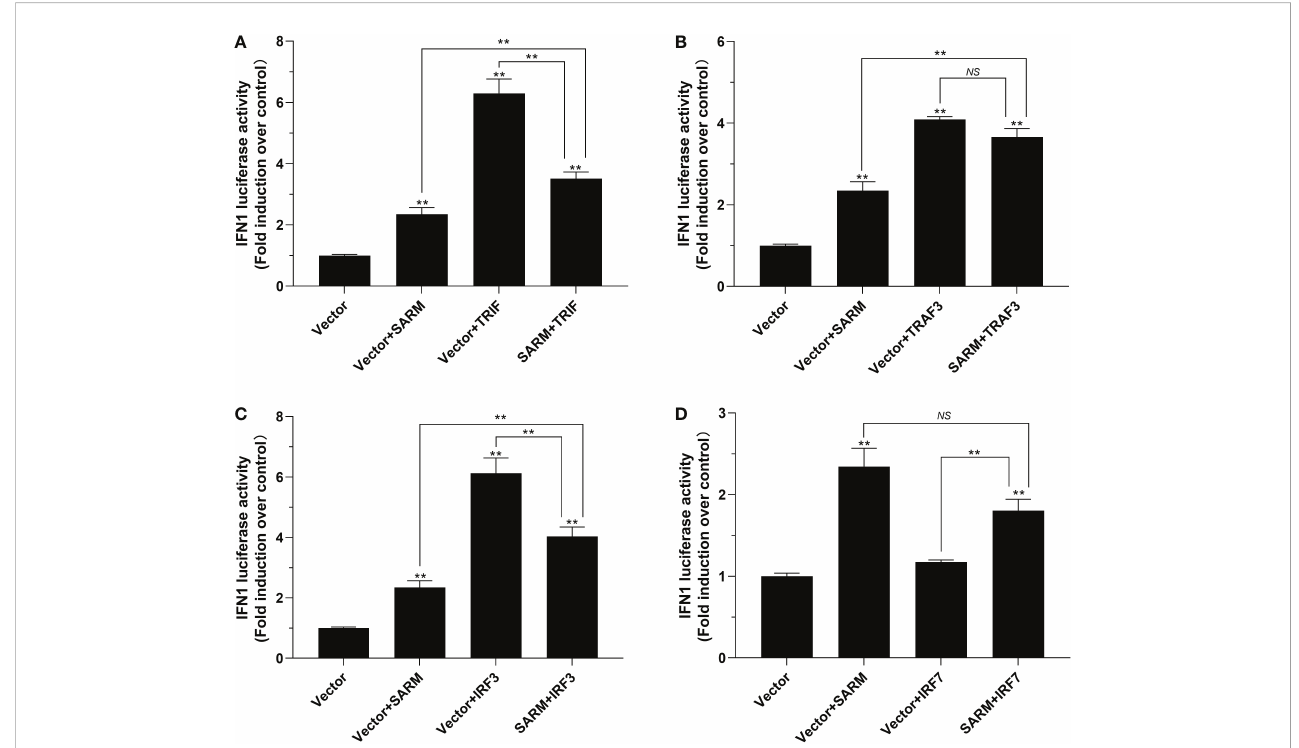
FIGURE 9 The role of Lc- SARM in the regulation of type I IFN signaling. The associations of Lc- SARM with Lc- TRIF (A) , Lc- TRAF3 (B) , Lc- IRF3 (C) and Lc- IRF7 (D) in the type I IFN promoter activation were analyzed by luciferase reporter assays. HEK 293T cells seeded in 24-well plates were co-transfected with 100 ng of pGL4-IFN1-pro and 10 ng pRL-TK together with 100 ng of pcDNA3.1-SARM, pcDNA3.1-TRIF, pcDNA3.1-TRAF3, pcDNA3.1-IRF3, and pcDNA3.1-IRF7 alone or in a combination of two as described above. At 24 h post transfection, the cells were harvested and used for the detection of luciferase activities. All data are presented as mean of three independent experiments, with bars representing the SE. * P < 0.05; ** P < 0.01; NS, not signi fi